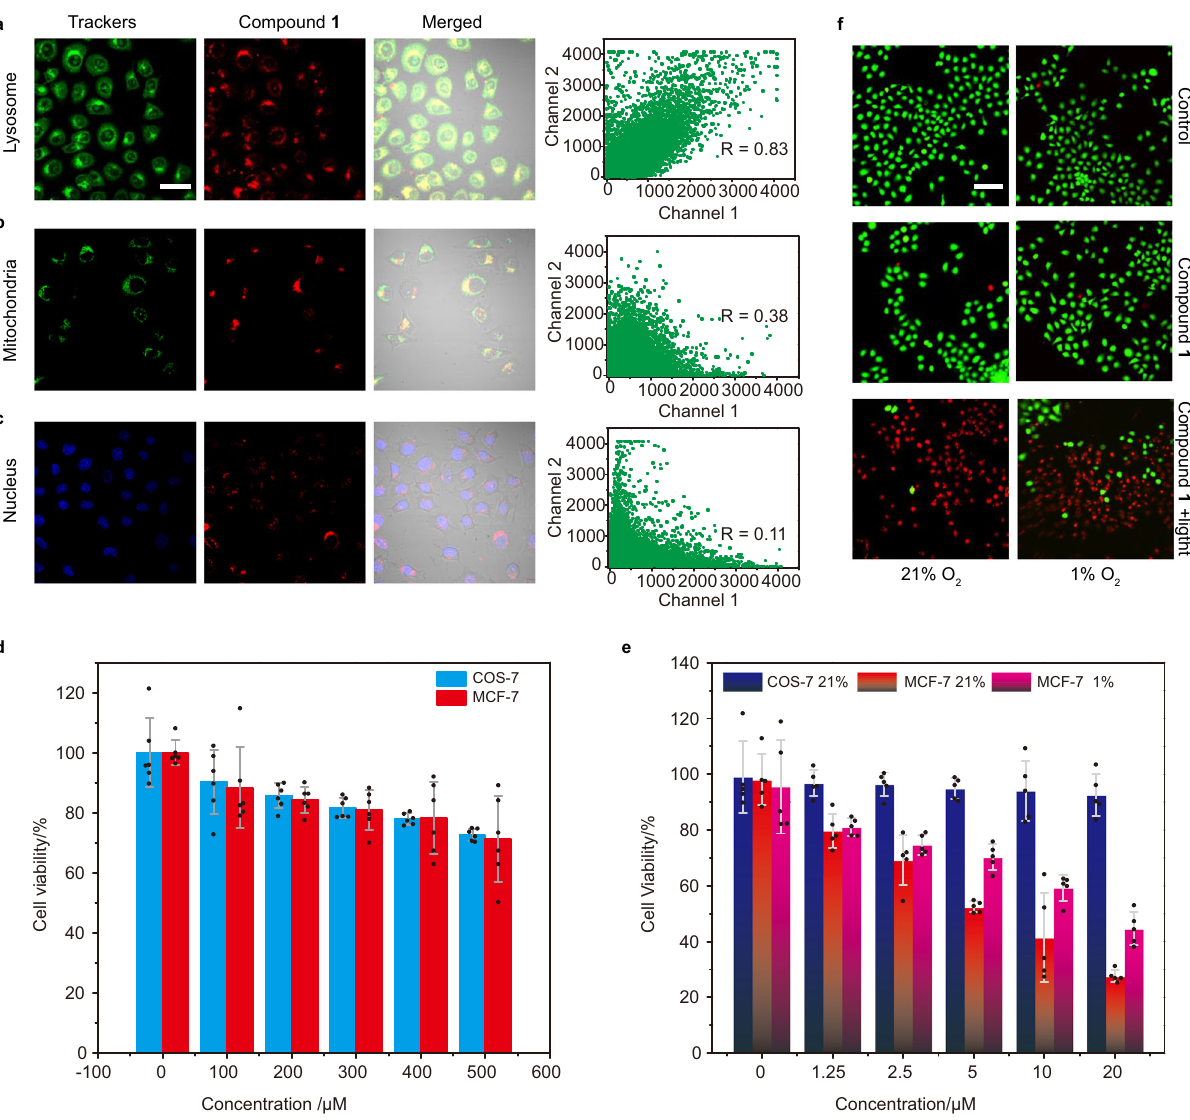
Fig. 4 Cellular uptake and in vitro PDT effect of compound 1. Subcellular colocalization images of compound 1 (10 μ M) in MCF-7 cells with a lysosome- localized tracker LysoTracker Green (1 μ M), b mitochondria-localized tracker Rhodamine 123 (1 μ M), and c nuceu-localized tracker Hochest 33324 (1 μ M), respectively. a – c right panel represents the colocalization coef fi cient of compound 1 and each tracker is 0.83, 0.38, and 0.11, respectively. Scale bar: 30 μ m. d Dark toxicity of compound 1 on COS-7 cells and MCF-7 cells under normoxia. Data in ( d ) are presented as mean ± s.d. derived from n = 6 independent biological samples. e Cell viability of COS-7 cells and MCF-7 cells treated with increasing concentrations of compound 1 after exposure to white-light irradiation for 10 min (white light 20 mW/cm 2 ). Data in ( e ) are presented as mean ± s.d. derived from n = 5 independent biological samples. f Live/dead cell costaining assays using Calcein-AM and propidium iodide as fl uorescence probes under normoxic (21% O 2 ) or hypoxic (1% O 2 ) conditions (green fl uorescence for live cells, red fl uorescence for dead cells, white light 20 mW/cm 2 for 10 min). Scale bar: 100 μ